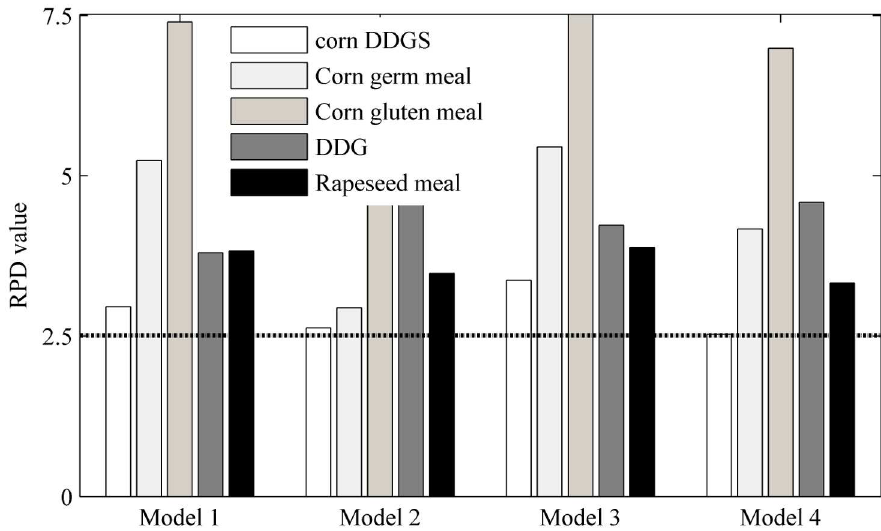
Fig 3. The RPD value for different kinds of plant feed materials in different NIR models. Model 1 to Model 4 stand for full spectrum specific models, full spectrum hybrid model, VIP scores specific models and VIP scores hybrid model,